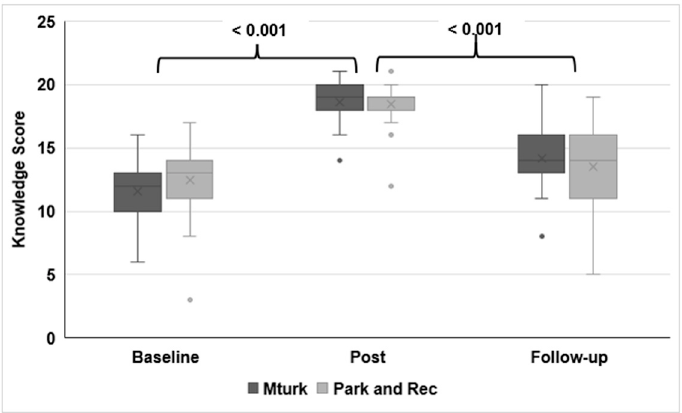
Figure 1. Box and Whisker plot showing change in knowledge score for the groups over time.